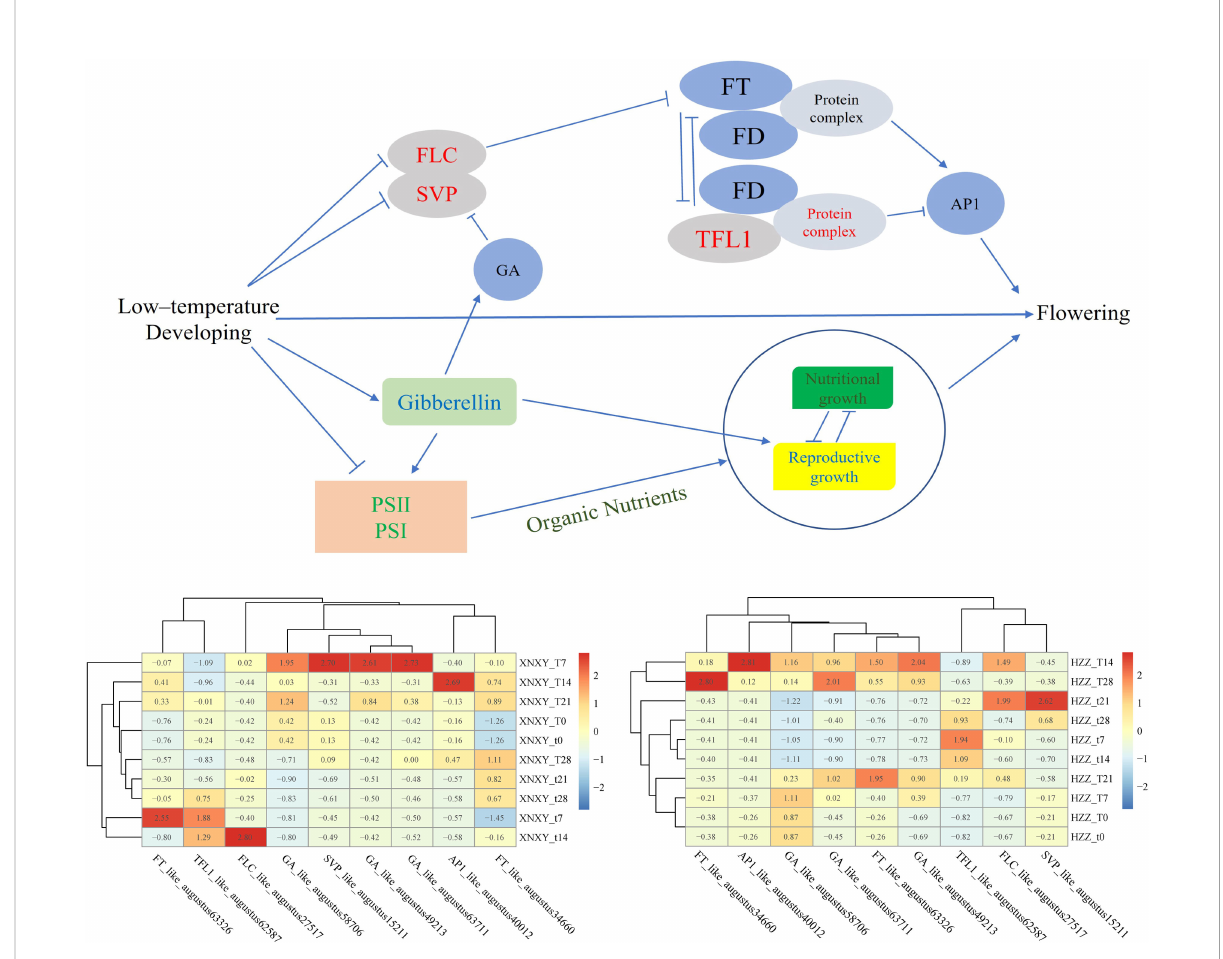
FIGURE 7 Regulation model for low temperature promotion of fl owering in Eryngium. The gene expression values in the heat map are obtained from the original values after homogenization by the scale function. ‘ T ’ represents the low-temperature treatment group and ‘ t ’ represents the blank control group treated at 25°C, ‘ XNXY ’ represents the ‘ Xiangnong Xiangyun ’ and ‘ HZZ ’ represents the ‘ Hei Zhenzhu ’